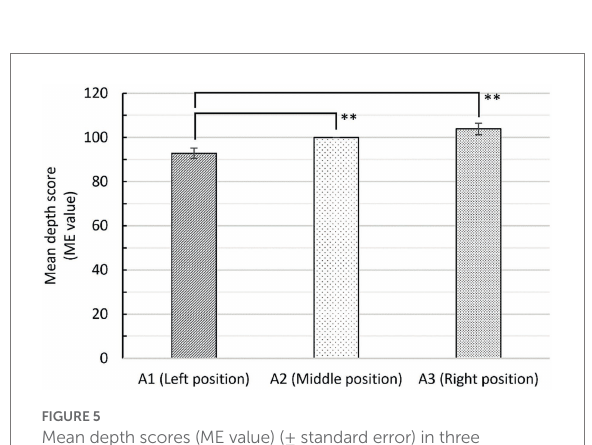
FIGURE 5 Mean depth scores (ME value) (± standard error) in three positions in Task 1. **Significance ( p <